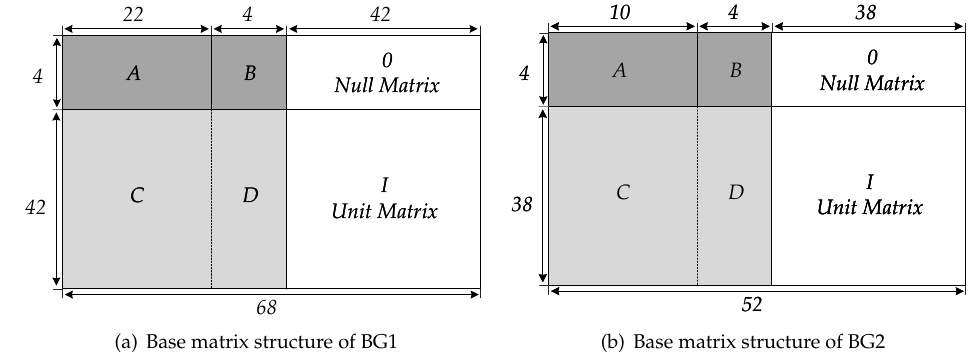
Figure 3. Region division and parameters of base